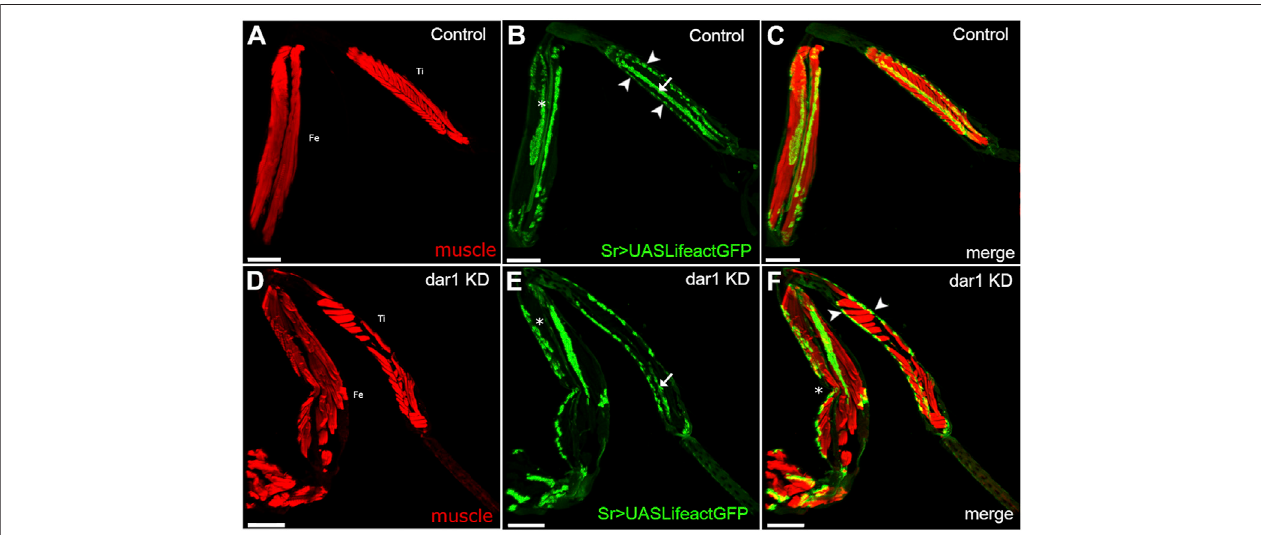
FIGURE 3 | Knockdown of dar1 expression in long tendons alters myotendinous architecture of adult leg. Combination of confocal images from adult leg cryosections(Tibia:Ti,Femur:Fe);musclesarestainedwithstainedphalloidin(red).TendonsarevisualizedwithLifeact.GFP(green) (A – C) Ineachsegmentofcontrolsr- gal4,dar1 3010/+ > UAS-Lifeact.GFP legs, major muscles display a feather-like pattern. For instance, fi bers of the muscle in the ventral tibia are attached on one side to the tarsi depressor long tendon (arrow in B) and on the other to an individual cuticle muscle attachment site (arrowheads in B) (D – F) on this cryosection of sr-gal4, dar1 3010/+ > UAS-Lifeact.GFP,UAS-dar1RNAileg,thetiltinthedorsalfemurisabsent(asteriskinEcomparedtoB)andthelongventraltendonappearsshorterinthetibia (arrow in B and E). Alteration or absence of these long tendons leads to the misattachments of muscle fi bers with both ends attached to cuticular attachment sites (arrowheads inF)leadingtotheformationoftransversal fi bers.Note thatdisruption ofmyotendinous architectureseems toaffect themorphologyoftheleg,withapinch in the femur segment (asterisk in F). number of leg segment observed after cryosection (control n (cid:2) 5, dar1 KD n (cid:2) 6). Scale bar 100 μ m.